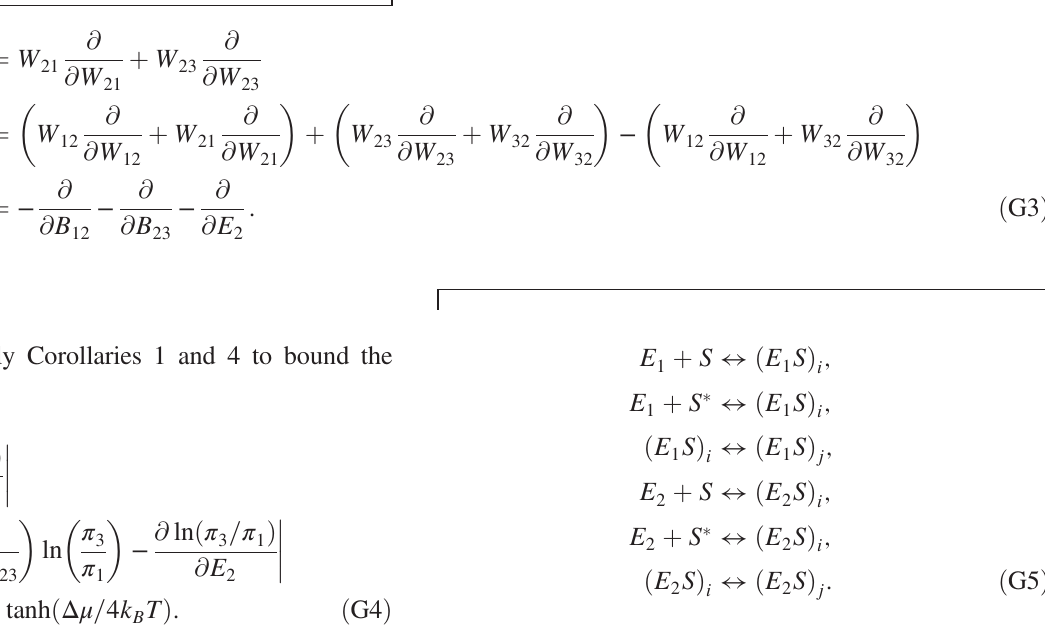
steady-state ratio ½ S (cid:4) (cid:3) = ½ S (cid:3) can exhibit unlimited sensitivity to changes in E 1 ;